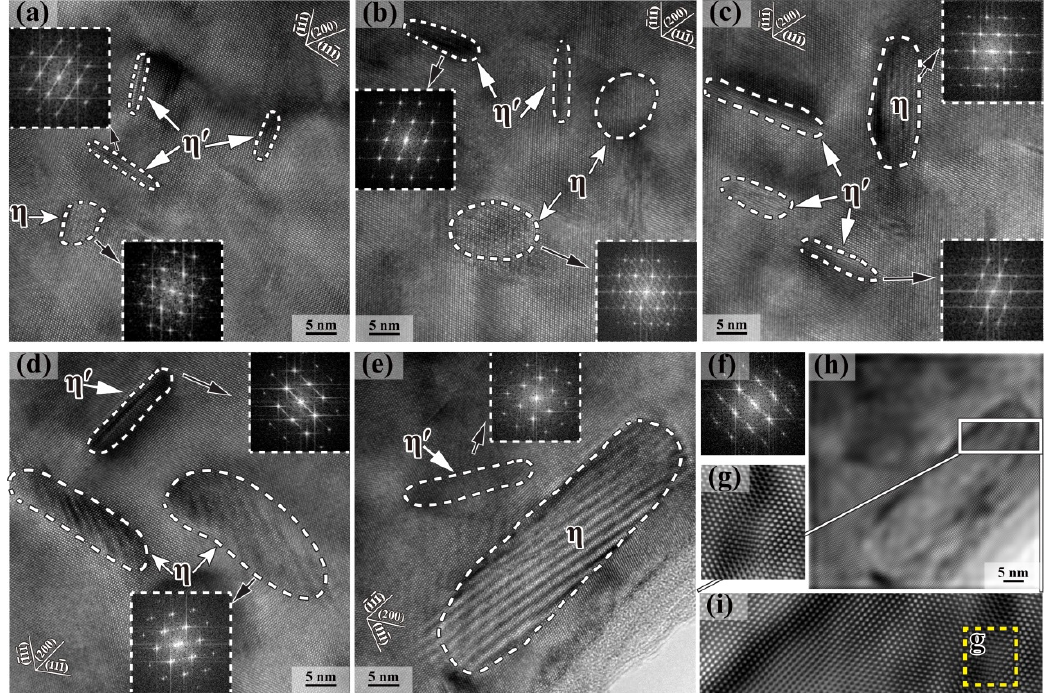
Figure 6. HRTEM images of the precipitates viewed along <110> Al orientation in 7085 alloy after various heat treatments: ( a ) sample I (25 °C), ( b ) sample II (100 °C), ( c ) sample III (125 °C), ( d ) sample IV (150 °C), ( e ) sample V (175 °C), ( f ) corresponding FFT pattern of η phase in ( e ), ( g ) is from the yellow dashed frame in ( i ), ( h ) is the corresponding inverse FFT image of ( e ), and ( i ) is from the white solid frame in ( h ).